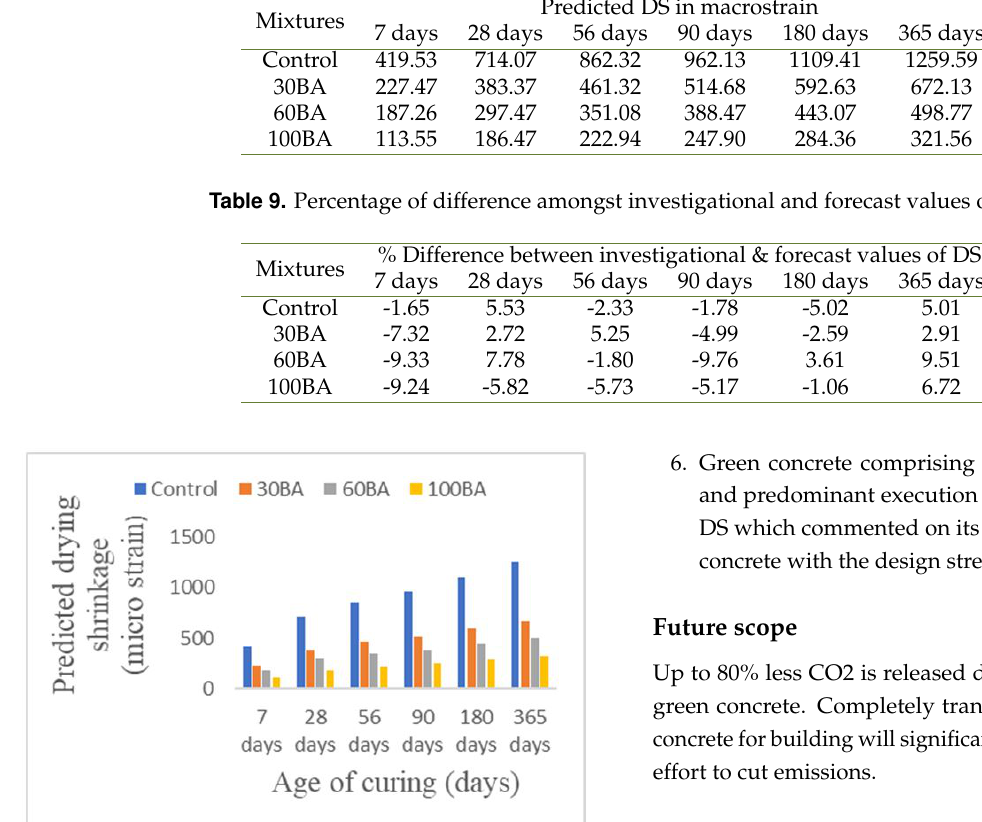
Table 8. Predicted values of DS.